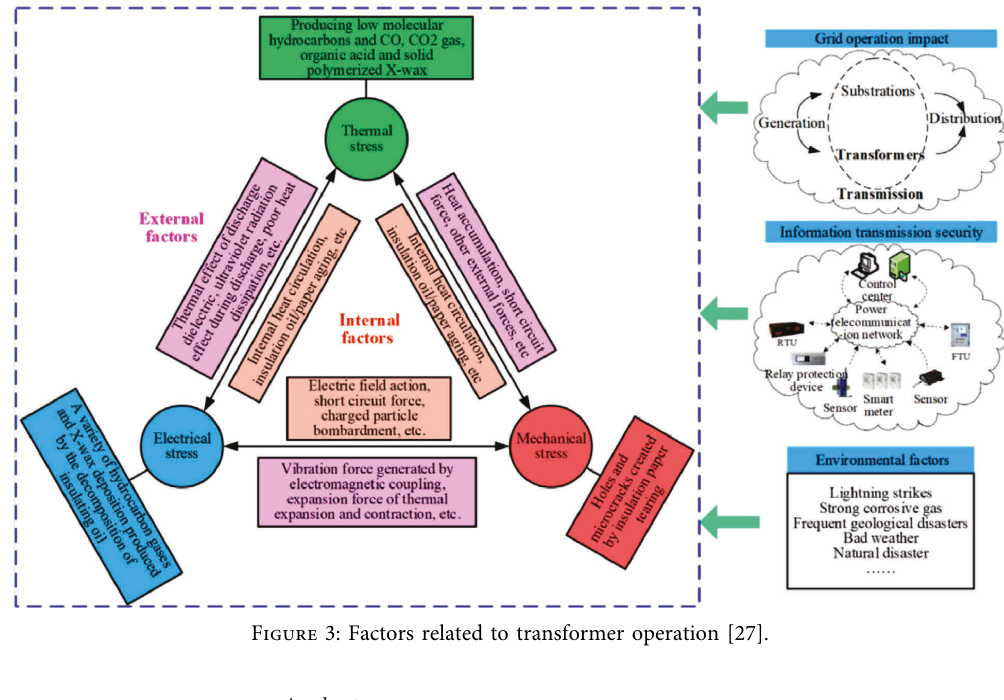
Figure 3: Factors related to transformer operation [27].